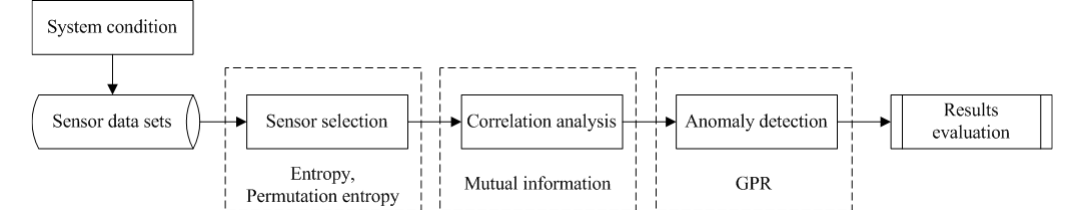
Figure 4. Framework of sensor selection and data anomaly detection.